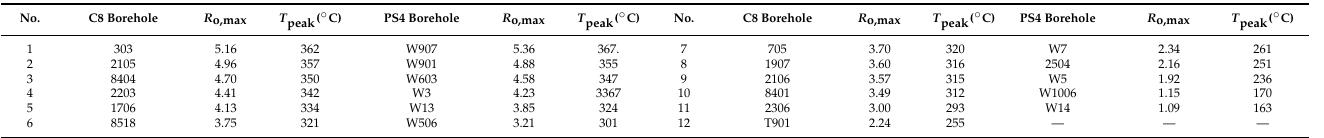
Table 2. The contact metamorphism coal vitrinite reflectance (% R o,max ) and the calculated paleotem- perature ( T peak / ◦